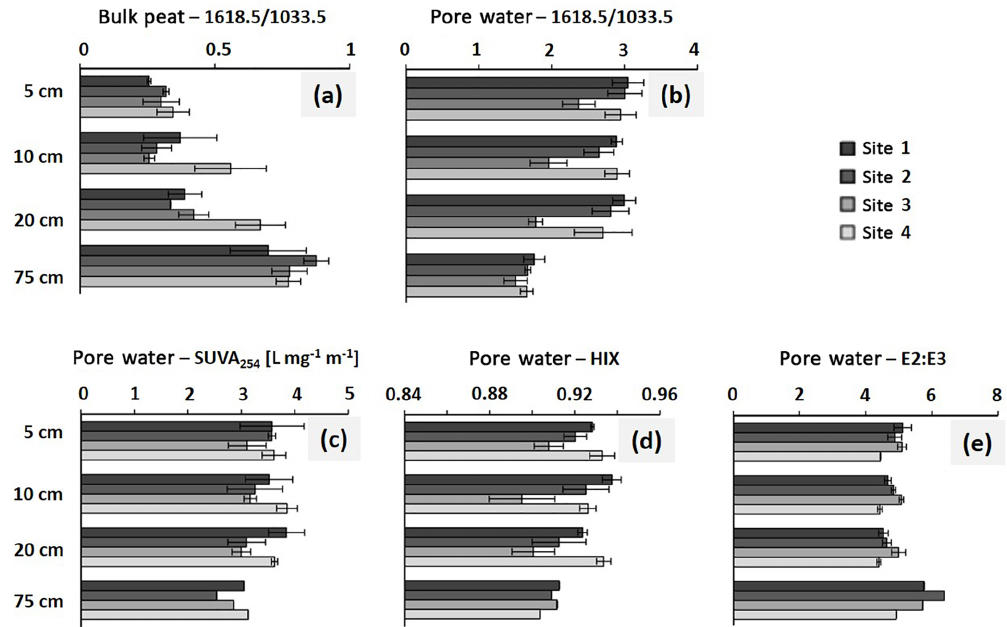
Figure 2. FTIR ratios 1618.5 / 1033.5 in bulk peat (a) and pore water (b) as well as SUVA 254 indicating aromaticity, (c) , HIX, humification index, (d) and E2:E3, indicative of molecular size and aromaticity, (e) for pore-water samples from sites 1 to 4; n = 3. Error bars indicate ±